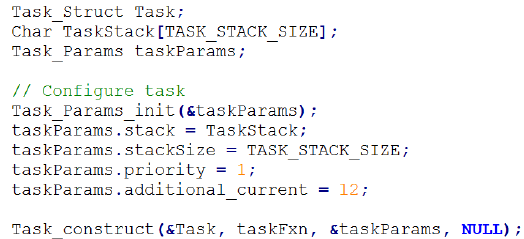
Figure 5. Modified method to instantiate task taskFxn with the addition of new parameter additional_current to inform the task scheduler of the required additional current (in this case 12 mA) that will be drawn when that task runs.